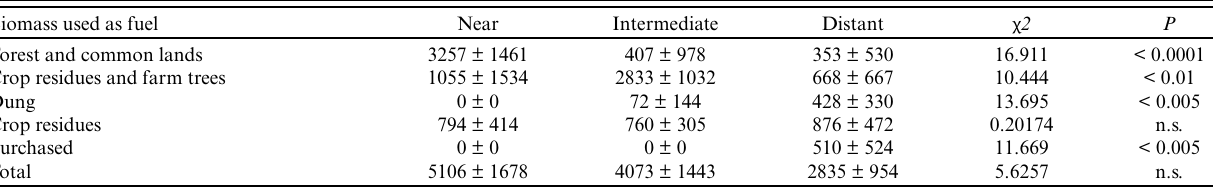
Table 5 . Comparison of the mean quantity of biomass in kg household -1 year -1 from different sources used as household fuel in the three zones of the study area (near, intermediate, and distant to Munesa Forest). Standard errors are given after the “±” signs. χ 2 and P values are given for Kruskal–Wallis tests that compared medians between the three zones.